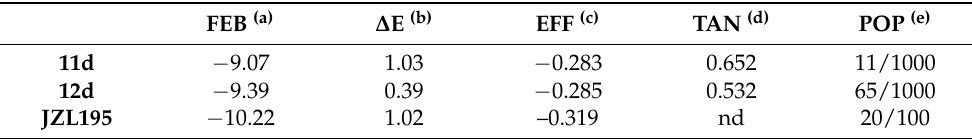
Table 7. Docking scores for compound 11d and 12d to FAAH.